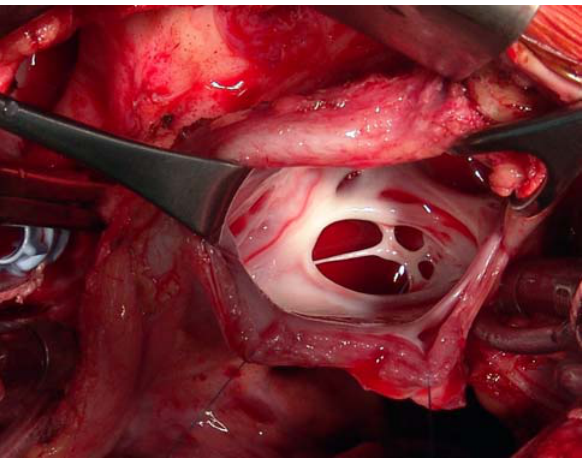
Fig.3 – Comunicação interatrial ostium secundum com lâmina da fossa oval